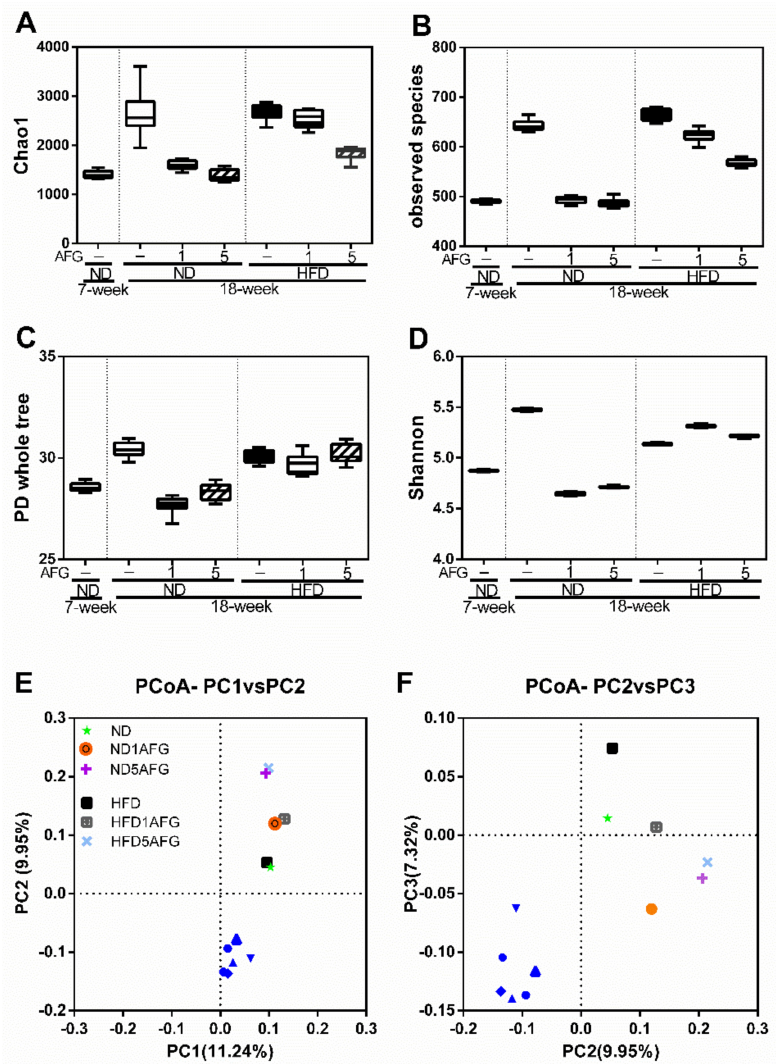
Figure 3. The diversity of gut microbiome. ( A – D ) The taxa richness of the gut microbiome assessed by α -diversity analyses using Chao1 value, observed species index, PD whole tree index, and Shannon index. The data represent the median and range of ten alpha rarefaction values. ( E – F ) The species compositions of the gut microbiomes were assessed by β -diversity analyses using principle coordinate analysis (PCoA) of the unweighted UniFrac distance matrices, which is showed in PC1 vs. PC2 and PC2 vs. PC3. Each dot represents the beginning (7-week) or ending point (18-week) of the experiment for eight rarefaction values in each